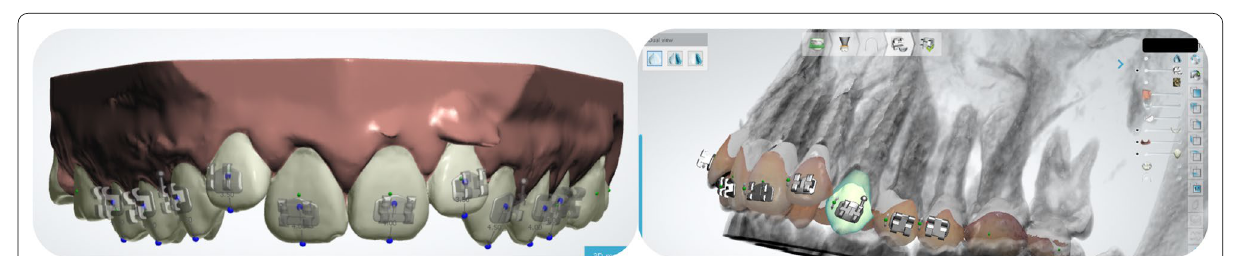
Fig. 3 Indirect digital bonding performed on OrthoAnalyzer